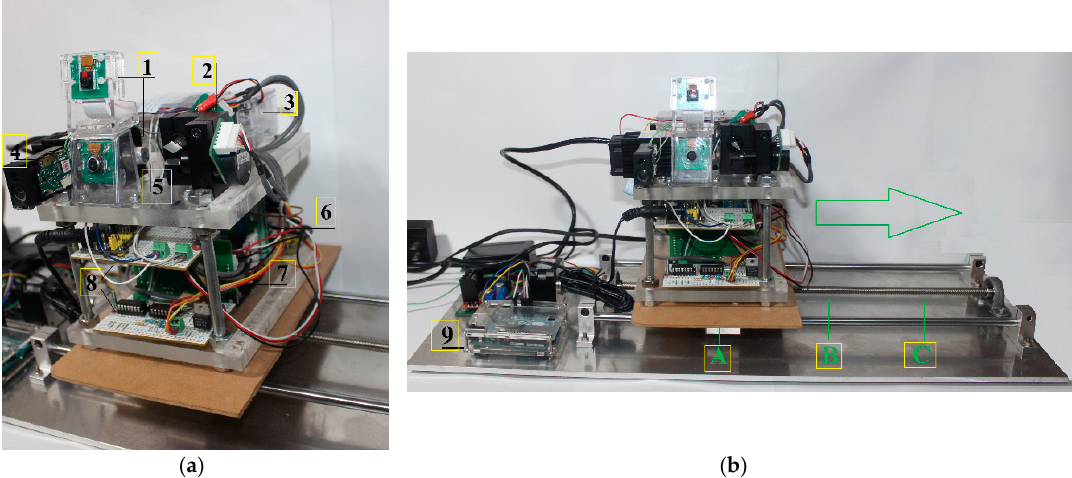
Figure 7. The prototype of the weed control device. ( a ) 1. Pointing to the cameras; 2. galvanometer; 3. Raspberry computer; 4. laser rangefinder; 5. laser; 6. power supply; 7. motor drivers, 8. electronic signal processing board, 9. Arduino board to control the position of the laser setup. ( b ) A, B, and C show the location of the crops.